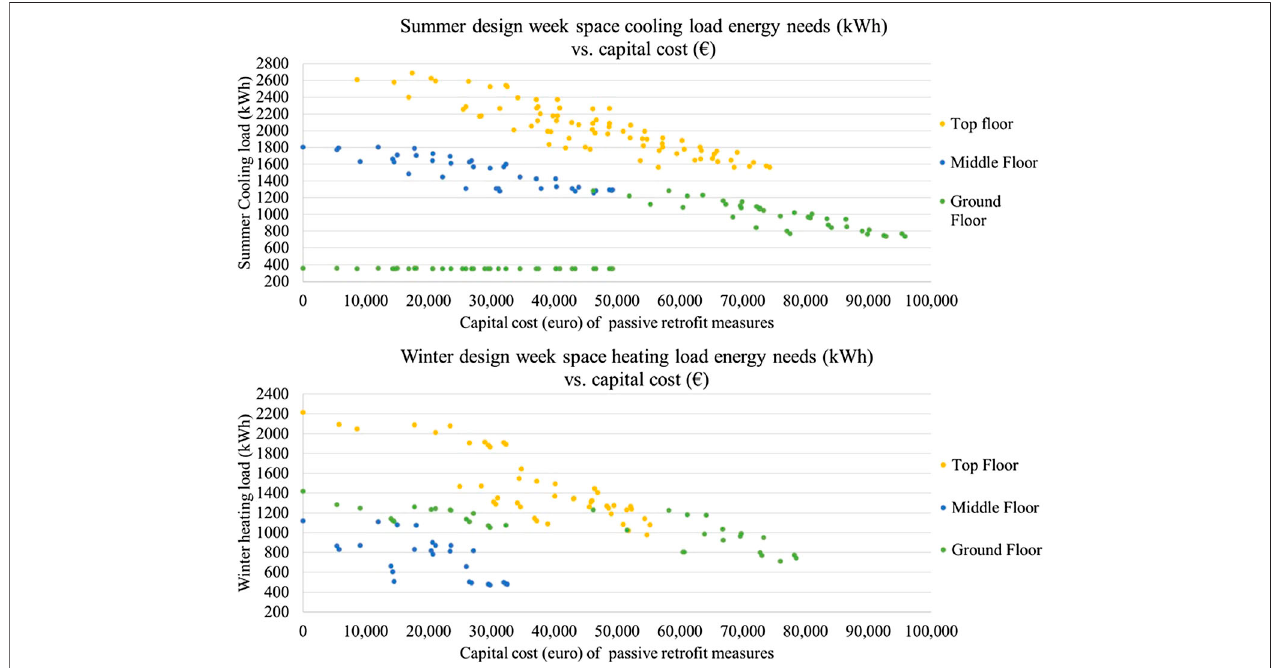
FIGURE 5 | Summer (top image) and winter (bottom image) design week cooling and heating load energy needs (kWh) vs. capital cost ( € ) of passive retro fi t measures for each fl oor.